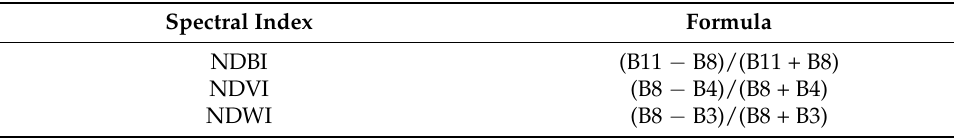
Table 3. The formula of the spectral